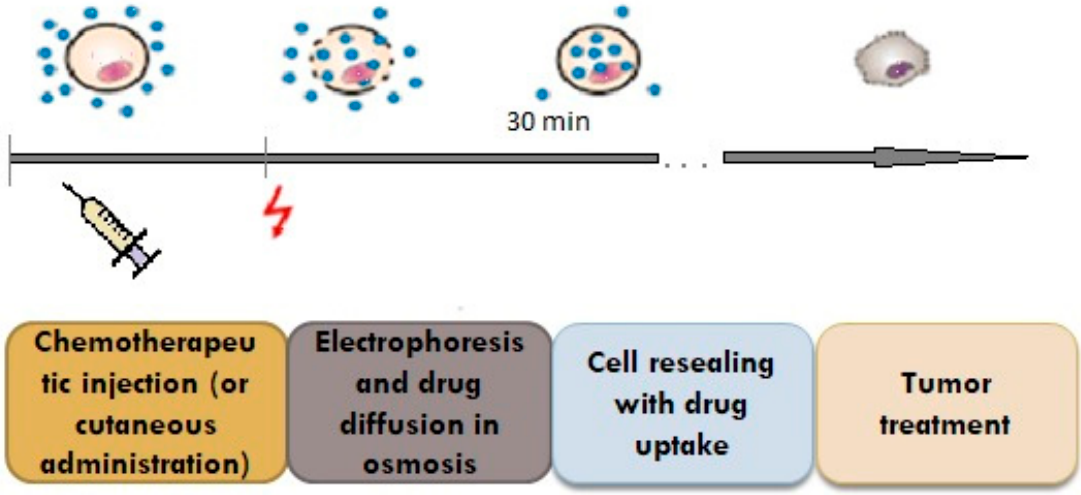
Figure 4. Penetration of the drug through the pores created by the impulse.